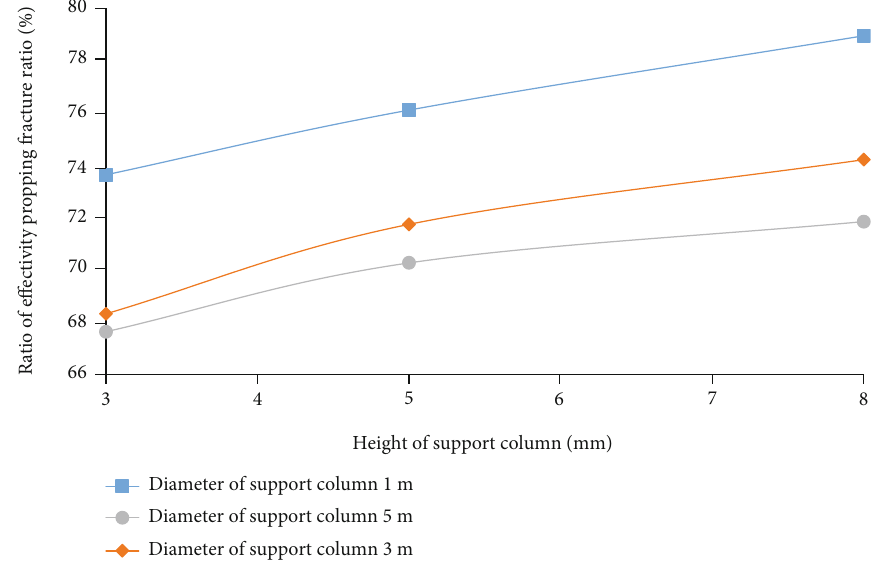
Figure 48: The e ff ect of proppant height on e ff ective supporting